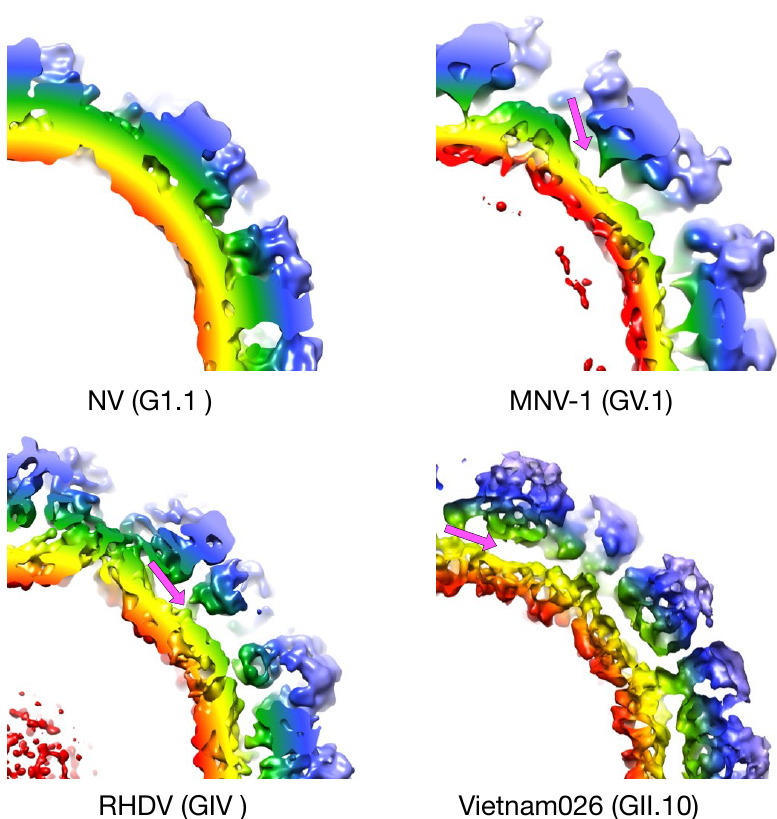
Figure 2. The P domain is observed to be “floating” above the shell surface in several different genotypes. Shown here are the cryo-EM image reconstructions of MNV, RHDV, and human Vietnam026 and of the crystal structure of NV. The gap between the P domains and the shell in these viruses are noted by the mauve arrows. The surface of NV is calculated from the atomic structure and all of the images are colored according the distance from the center of the particle. Note that while the P domain of NV is not detached from the shell, it contains the flexible linker between the P domain and the shell as in the other